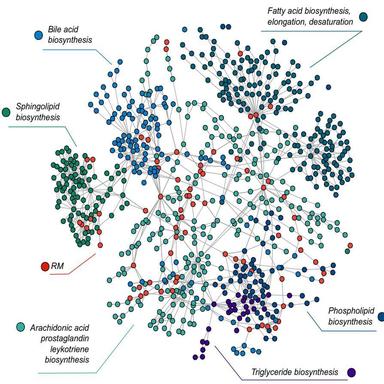
Metabolic pathways and RM in the metabolic network significantly differentiate (Benjamini and Hochberg false discovery rate p −1) between regressors vs. non-regressors. The dots represent the metabolites in the metabolic network, color-coded for each pathway, and the lines represent reactions between them. The red dots (marked RM) are the top scored RMs in the metabolic network. RMs, reporter metabolites. (This figure appears in color on the web.)